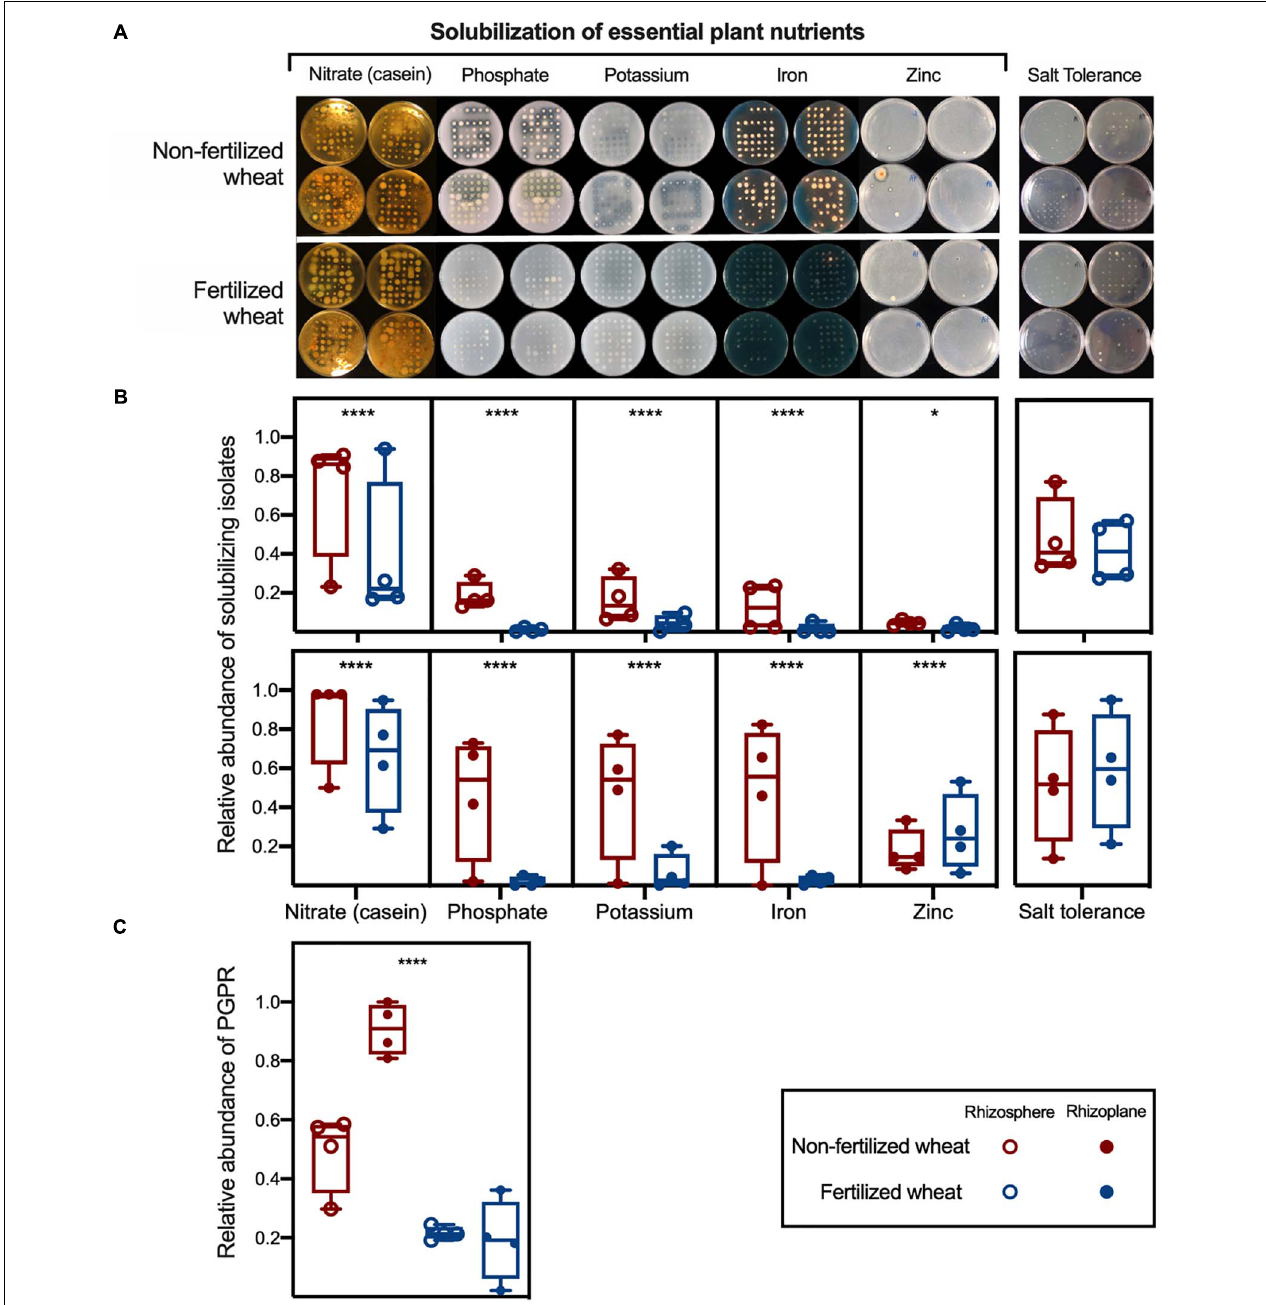
FIGURE 4 | Relative abundance of culturable rhizobacteria with plant growth-promoting traits isolated from wheat grown in soils with and without fertilizer. (A) Nitrate-, phosphate-, potassium-, iron-, and zinc-solubilization as determined by casein, PVK, AVK, CAS, and zinc carbonate agar, respectively. Casein, phosphate, potassium, and zinc solubilization are indicated by clear halos surrounding the colony whereas orange halos indicate iron solubilization. Salt tolerance as determined by 10TSA supplemented with 5% NaCl. Box plots show relative abundance of (B) solubilizing isolates and salt tolerant isolates and (C) relative abundance of PGPR isolates, as determined by functional bioassays; with median (line) and hinges at first and third quartiles (25th and 75th percentiles). Each point represents an isolate library ( n = 94) derived from rhizosphere (open circles) and rhizoplane (closed circles) samples. Single colonies were isolated from different non-selective agar and 10TSA respectively and inoculated in TSB (1/10th concentration) in a 96-well plate; sterile TSB (1/10th concentration) in 2 × wells were left uninoculated to act as a negative control. Significant differences as determined by Chi-squared tests are shown by “*” and “****” for p < 0.05 and p < 0.0001,